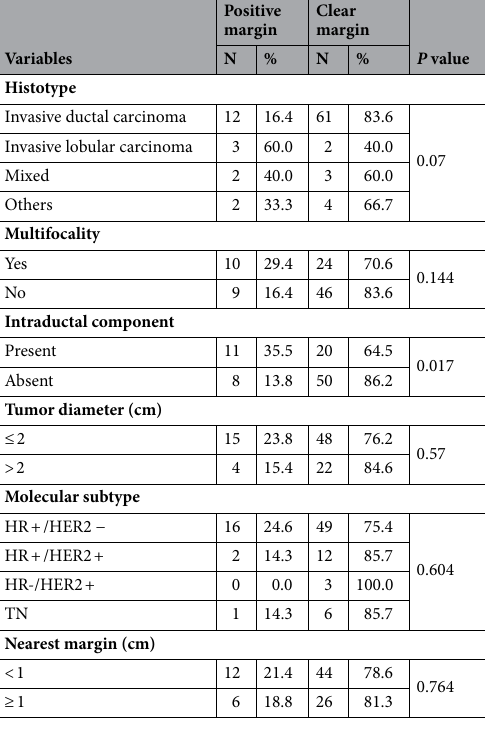
Table 3. Univariate analysis of risk factors for positive margins in frozen/permanent biopsies. HR hormone receptor, HER2 human epidermal growth factor receptor 2, TN triple negative.